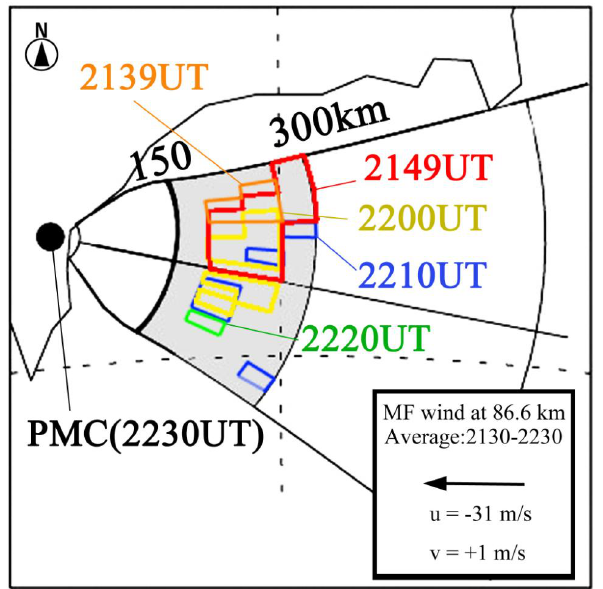
Fig. 8. Spatiotemporal variation of the strong echo region ( > 20dB) Figure 8. Spatiotemporal variation of the strong echo region (>20dB) for the ground 670 for the ground range between 150 and 300km. The wind vector at the PMC altitude (86.6km) scaled by the distance of wind advection range between 150 and 300 km. The wind vector at the PMC altitude (86.6km) scaled 671 for one hour is also by the distance of wind advection for one hour is also shown. 672